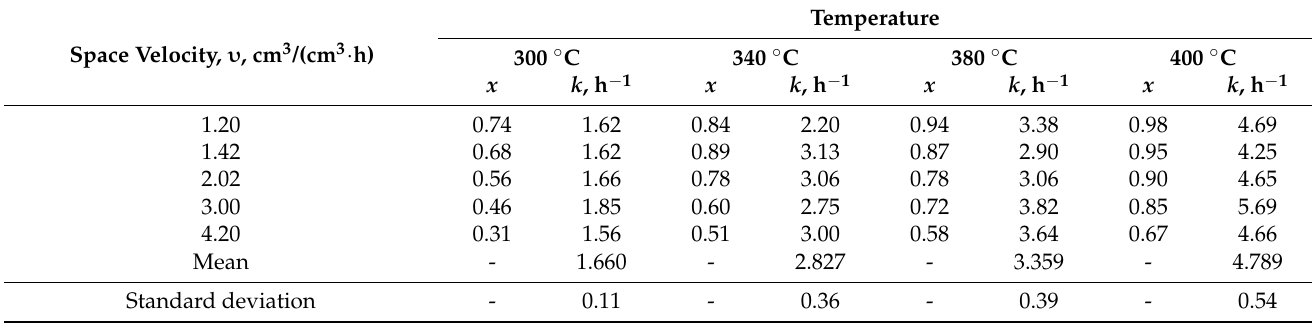
Table 1. Effect of the hour space velocity of the diesel fraction in the reactor on the degree of conversion of sulfur compounds x at p = 3.5 MPa and different temperatures (k—reaction rate constant).